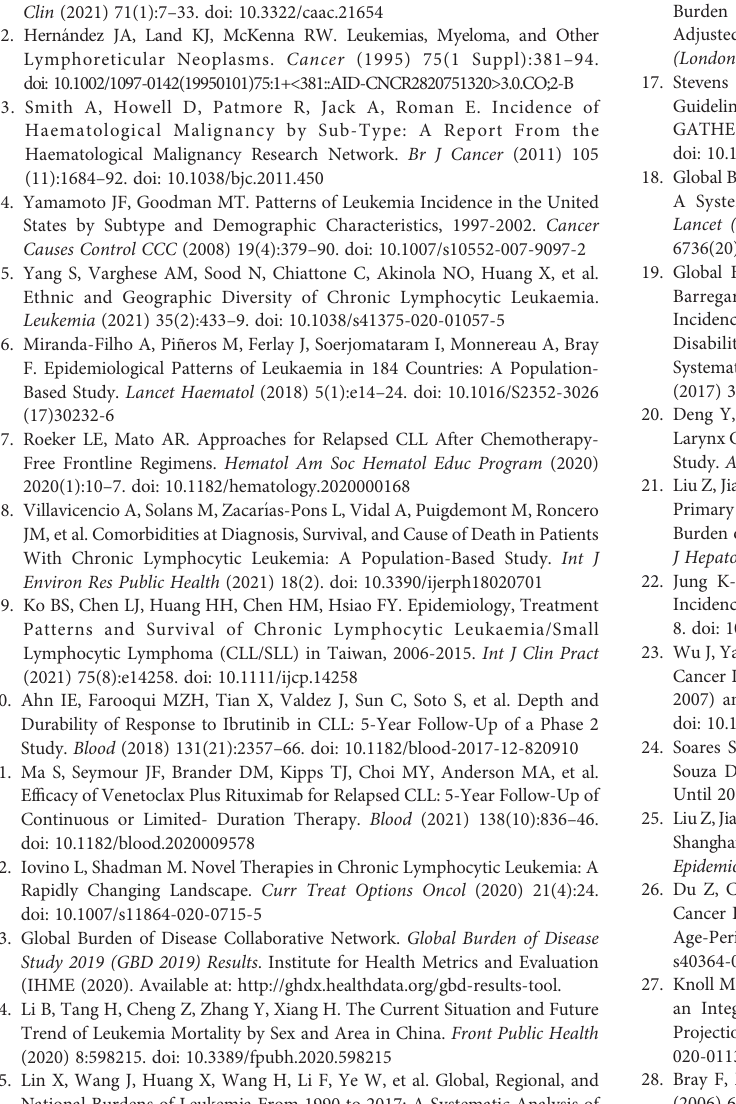
Supplementary Table S14 | The age and gender distribution of death cases and ASIRs of CLL in 2019. ASDR: age-standardized death rate, UI: uncertainty interval. Supplementary Table S15 | The age and gender distribution of DALYs and age- standardized DALY Rates of CLL in 2019. DALY: disability-adjusted life year, UI: uncertainty interval. Supplementary Table S16 | The age and region distribution of incident cases (95% UI) of CLL in 2019. ASIR: age-standardized incidence rate, UI: uncertainty